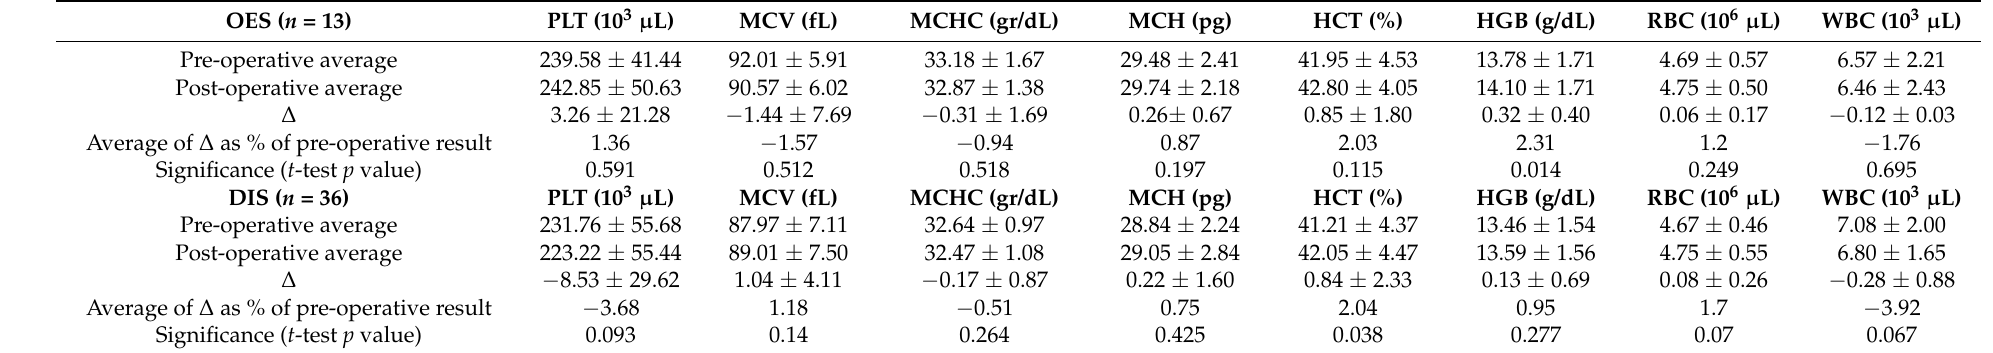
Table 5. Change between pre-operative and post-operative CBC stratified by suspected